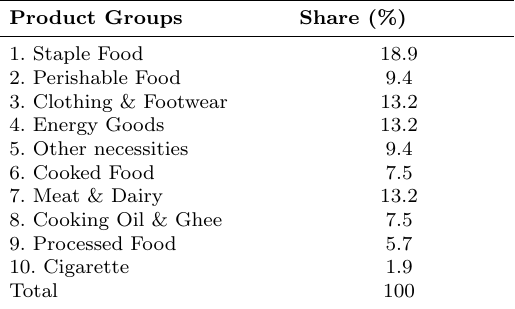
Table 1: Share of Product